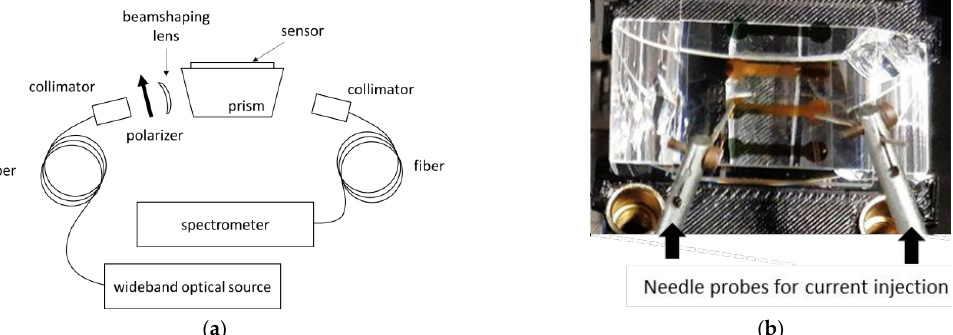
Figure 18. Spectral interrogation scheme based SPR set-up: ( a ) schematic view; ( b ) detail on the current injection using two needle probes.